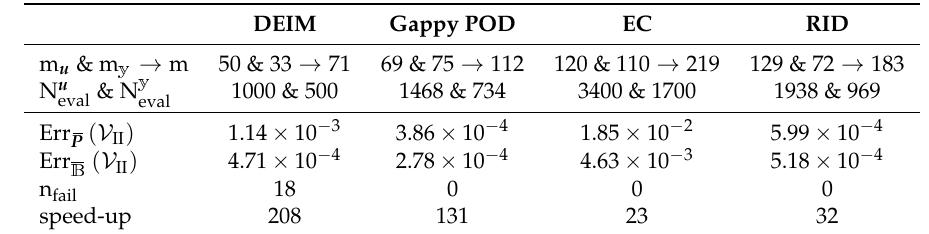
Table 4. Comparison of selected hyper-reduced models using a reduced basis with n u = 20 and n y = 10.